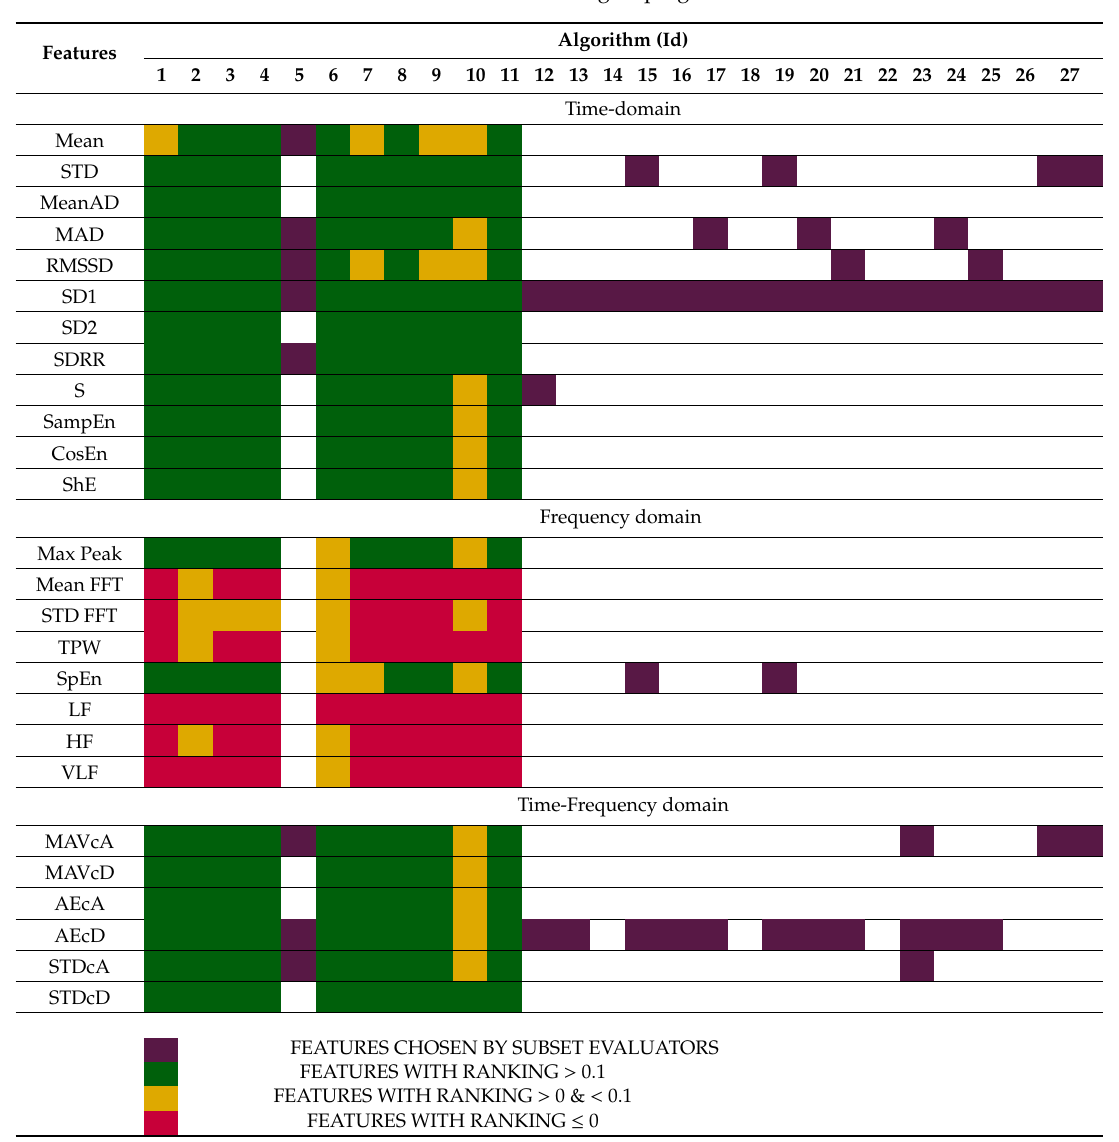
Table 2. Features